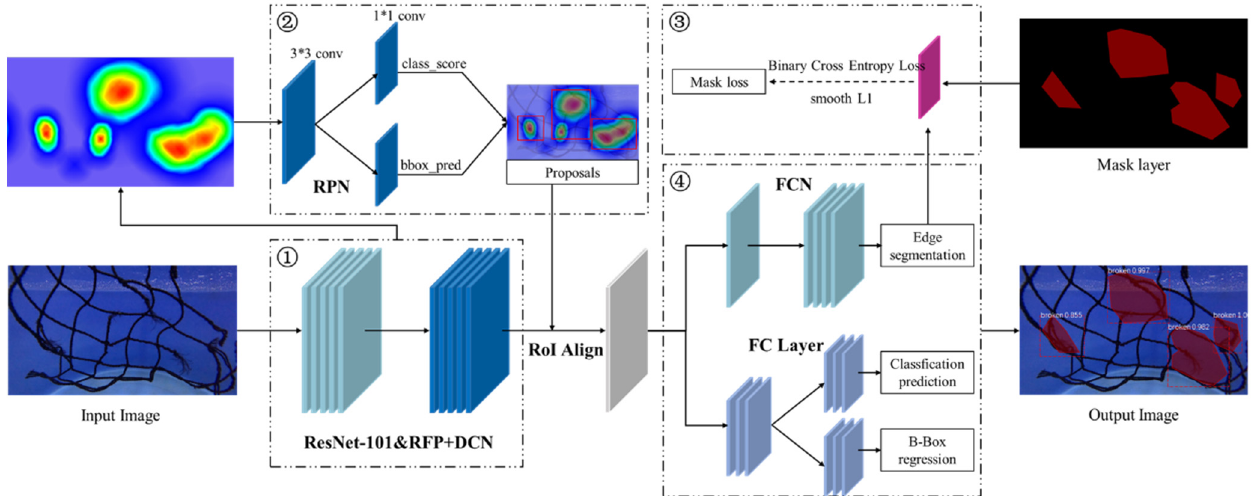
Figure 7. Schematic diagram of the netting damage detection model. Note: 1 (cid:13) indicates the backbone for feature extraction, 2 (cid:13) indicates the Region Proposal Network, 3 (cid:13) indicates the edge segmentation training branch, and 4 (cid:13) indicates the object detection and classification module.